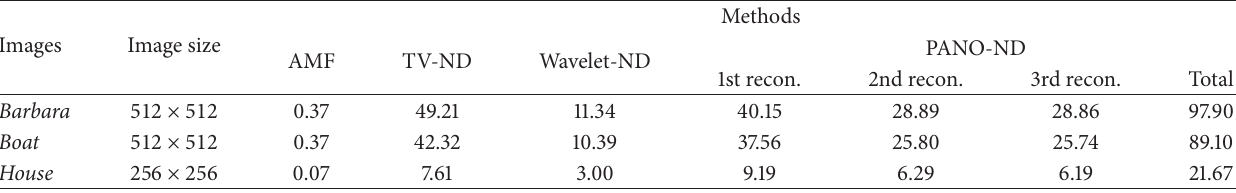
Table 2: Computational time of different methods (units: